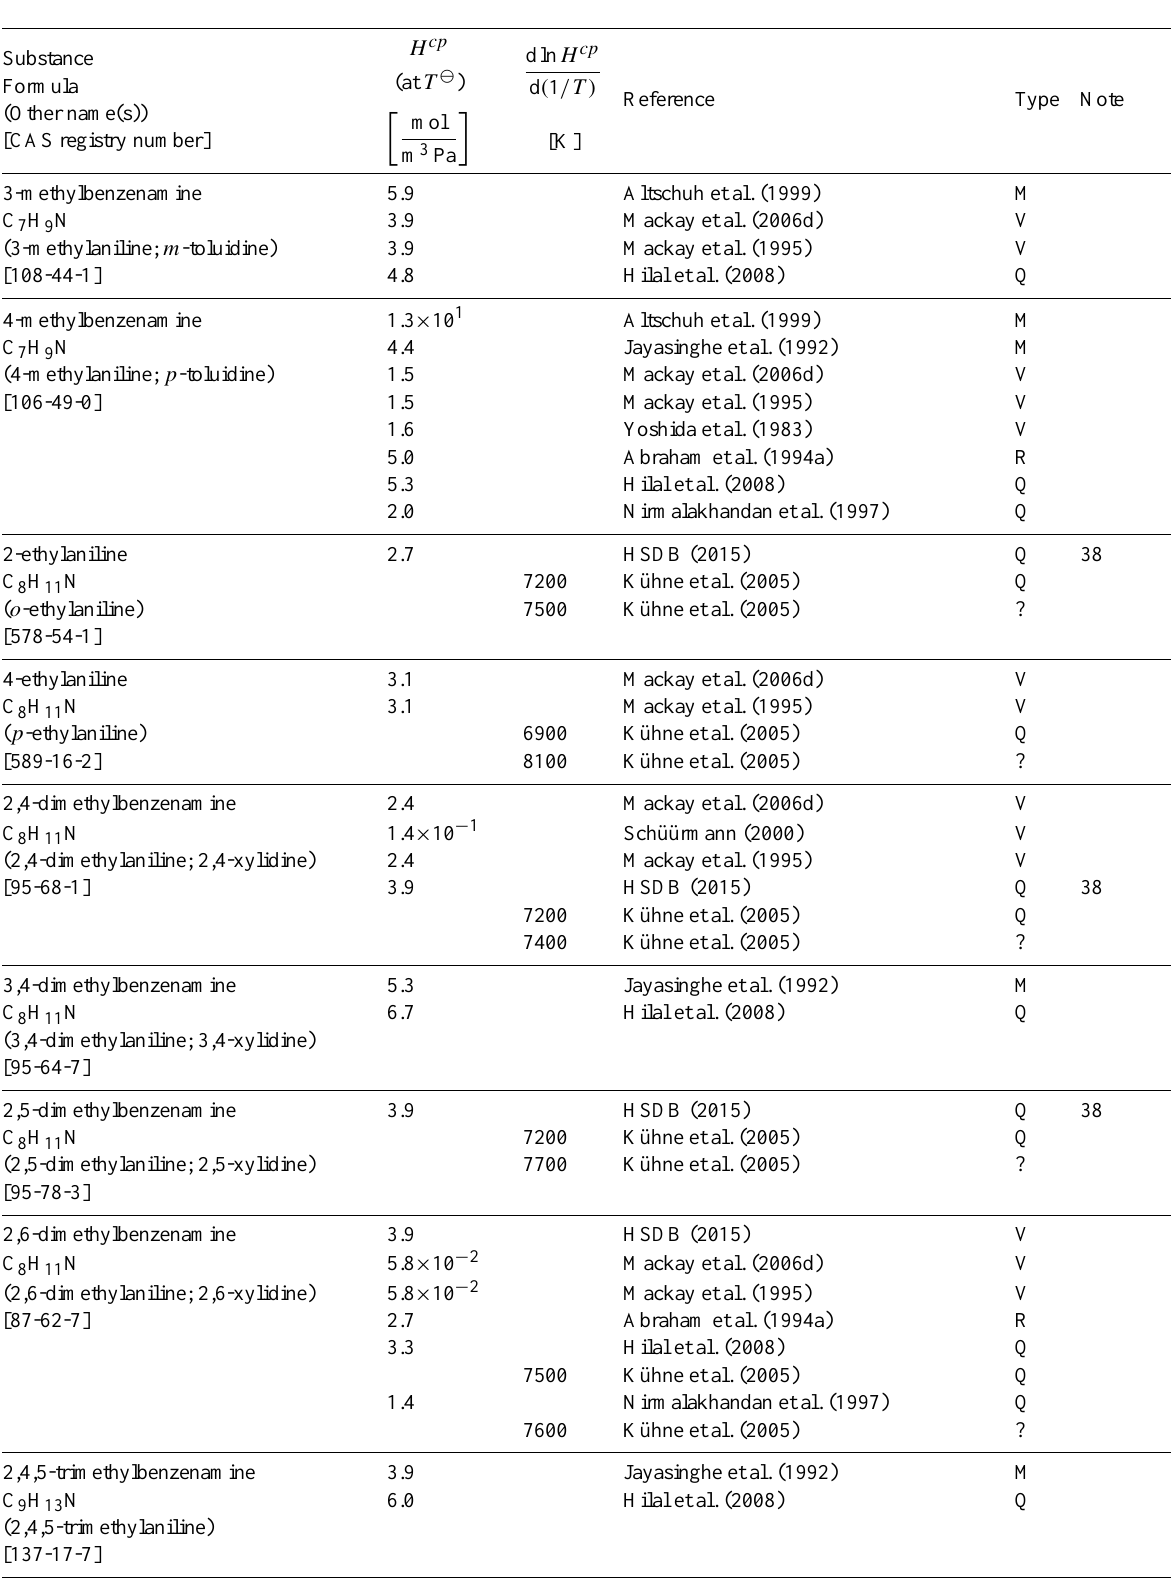
Table 6: Henry’s law constants for water as solvent